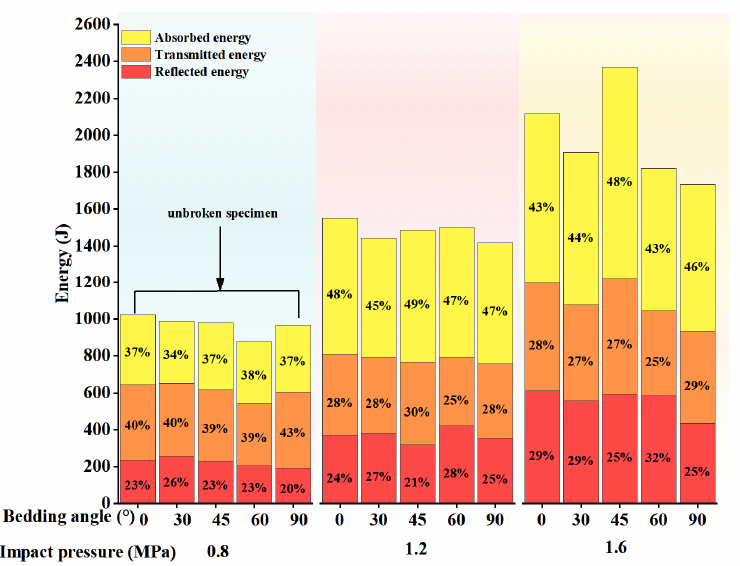
Figure 13. Energy proportions in the samples under different loading conditions.